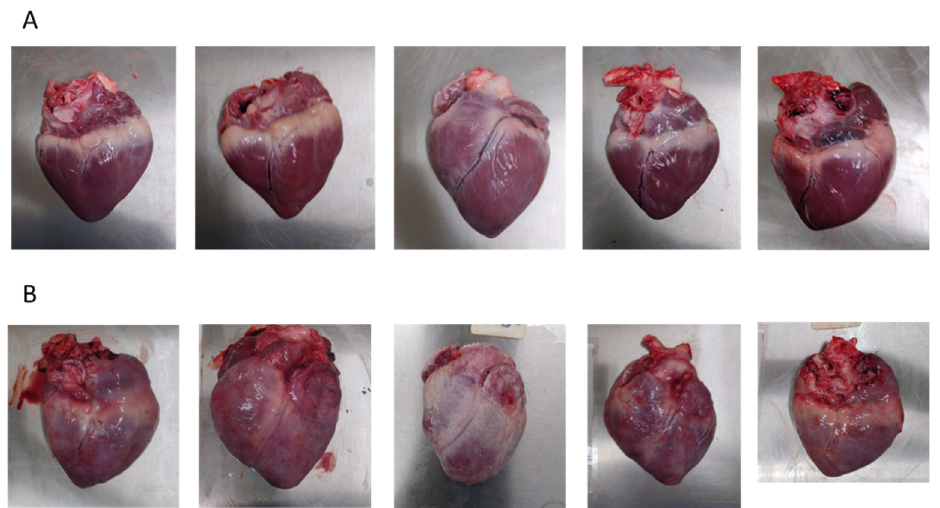
Figure 4. Gross-pathology after immunisation with ASFV-Kenya-IX-1033- ∆ CD2 and challenge with ASFV-Kenya-IX-1033. ( A ) Representative pictures of hearts of pigs after mock immunisation with PBS and challenge with ASFV-Kenya-IX-1033. ( B ) Representative pictures of hearts of pigs after immunisation with ASFV-Kenya-IX-1033- ∆ CD2 and challenge with